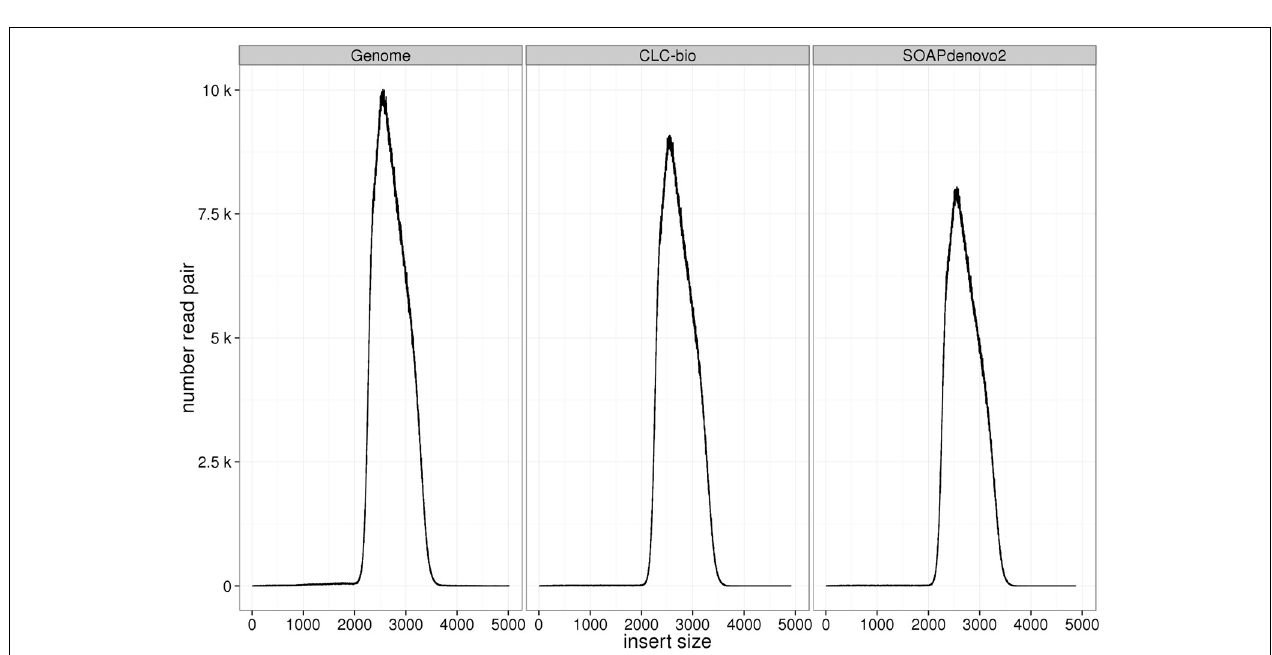
FIGURE 5 | Estimation of insert sizes for H. sapiens paired-end genomic libraries. Insert sizes are plotted for each target size using reads mapped against the H. sapiens reference genome, CLC, and SOAPdenovo2 assemblies.